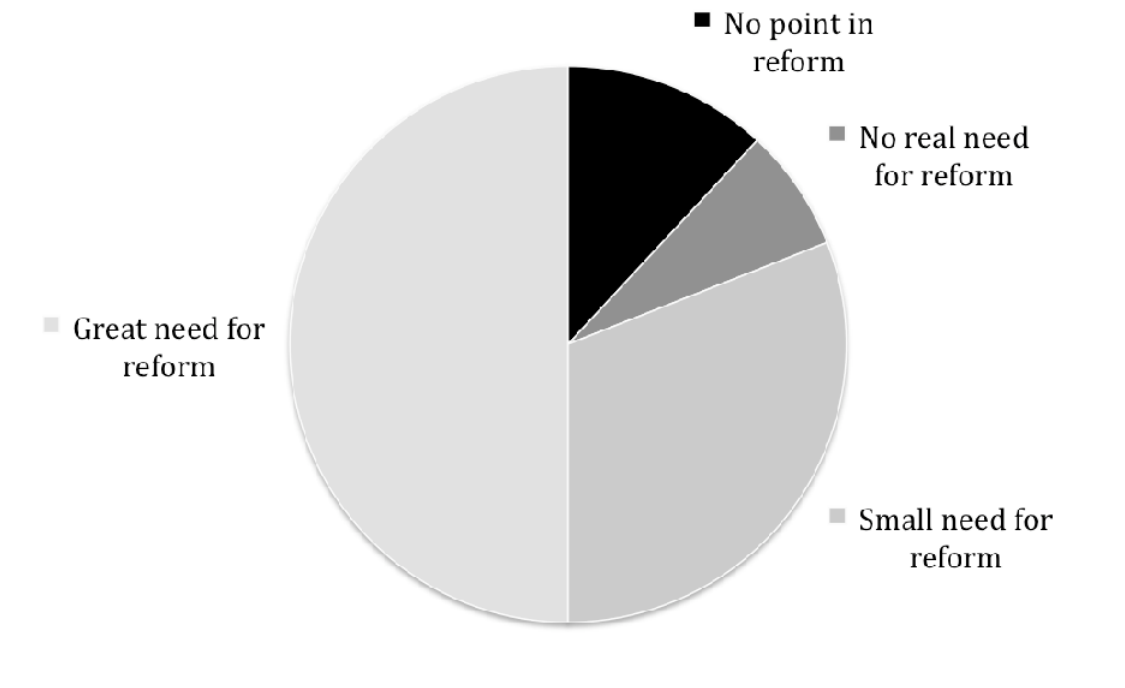
Figure 6. Delphi panellists distribution based on their view on reform for equal